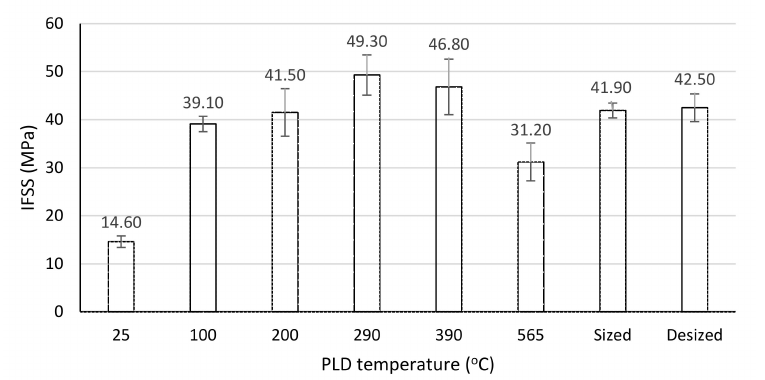
Figure 14. Interfacial shear strength (IFSS) of desized fibres PLD-treated at different temperatures. Values for sized (commercial) and desized fibres are shown for